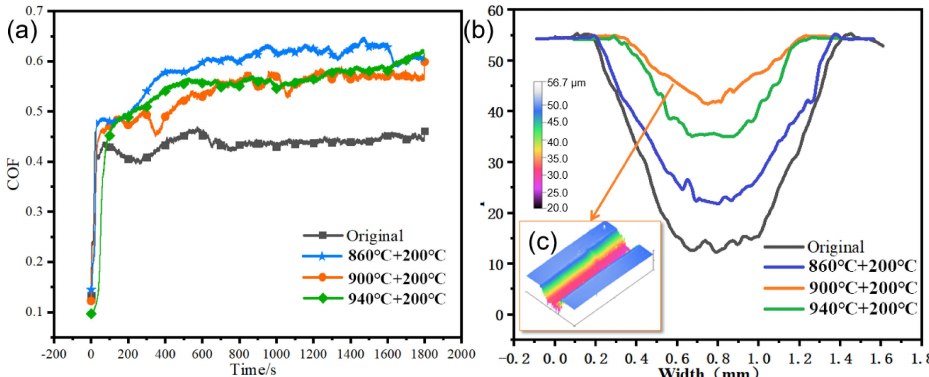
Figure 8. Friction and wear experimental data of NM500/Q345 clad plate wear—resistant layer (NM500) after austenitization at different temperatures: ( a ) friction coefficient; ( b ) wear scar section curve; ( c ) 3D morphology at 900 ◦